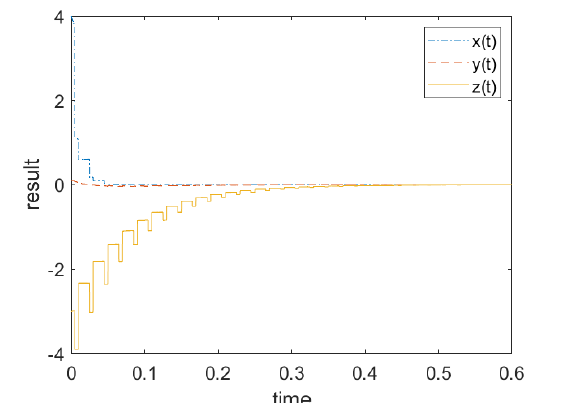
Figure 5. The time responding curves of system (58) with uncertain sandwich control and impulse time